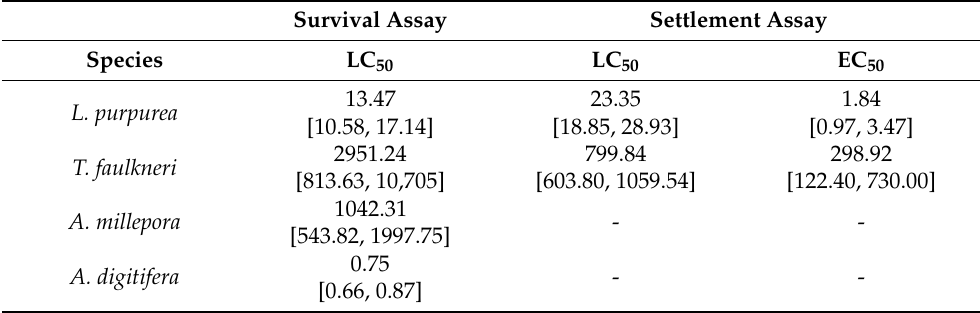
Figure 4. Concentration (measured)—Response (mean, n = 3) relationship of the larval experiments after 48 h BP3 exposure. Probit regressions with shaded areas indicating 95% confidence intervals illustrated for ( a ) survival and ( b ) settlement assays. Table 2. Biological endpoints after 48 h of BP3 exposure. Measured LC/EC 50 values in µ g L − 1 derived from probit regression analysis including lower and upper 95% confidence intervals in brackets shown for each species and experiment. Extended table including nominal toxicity thresholds can be found in Table